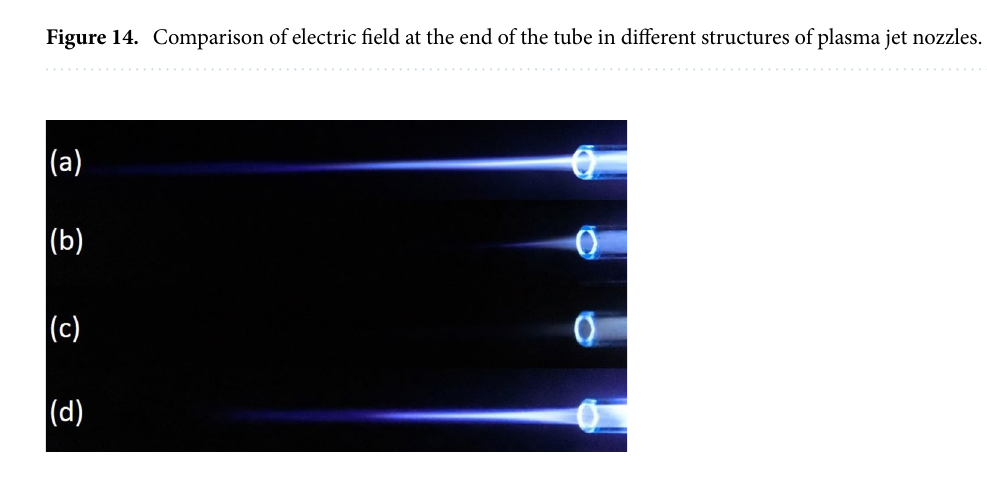
Figure 15. Comparison of plasma jet lengths according to the structures of Fig.